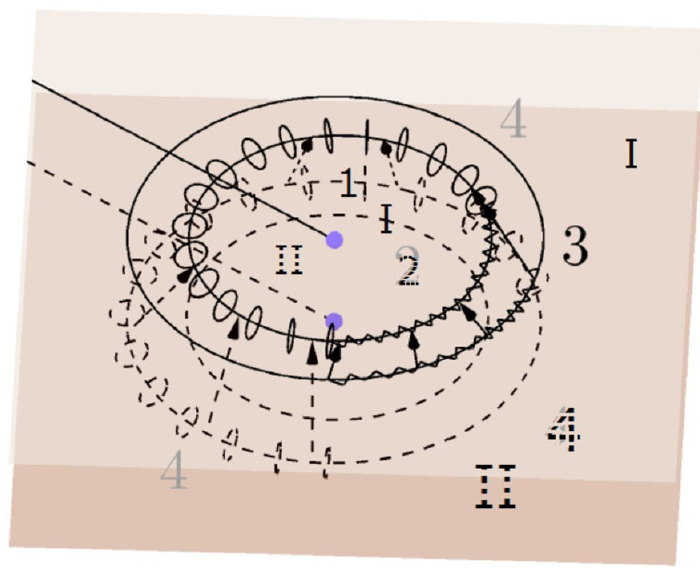
Figure 26 . On this (cid:12)gure we have drawn arrows to represent the gluings, but to avoid making the (cid:12)gure incomprehensively complicated we left out the arrows. That should have connected disc 2 with complement 3 by arrows crossing in between the arrows connecting disc 1 with complement 4 both marked . Similarly we left out the arrows that should have connected disc 2 and complement 4 both in the second layer